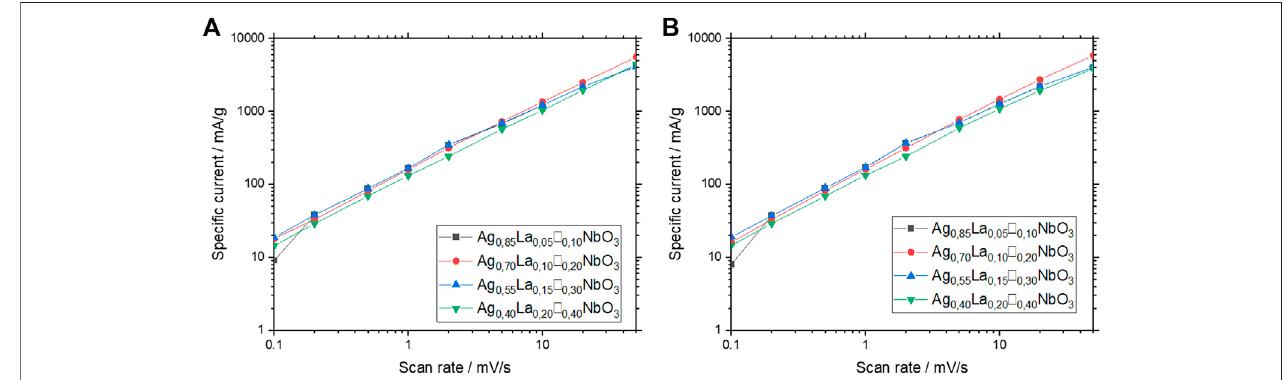
FIGURE 5 | (A) Linear regression from power law in the reduction peaks of Ag 1-3x La x □ 2x NbO 3 for different value of x. (B) Linear regression from power law in the oxidation peaks of Ag 1-3x La x □ 2x NbO 3 for different value of x.